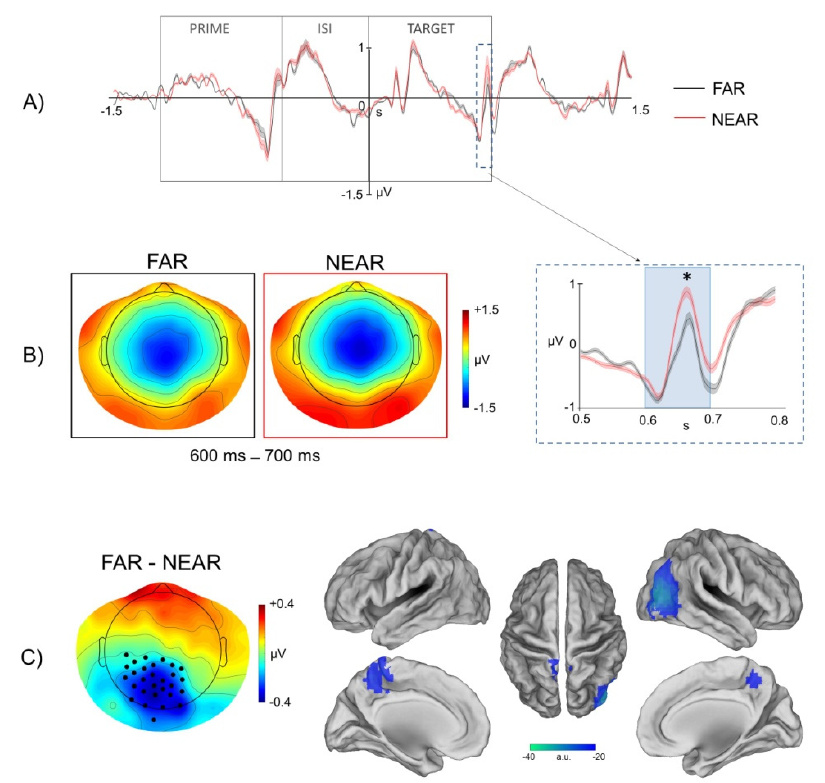
Figure 5. ERP modulation in the 600-700 ms interval. ( A ). Time course of the mean ERPs (black: far extrapersonal distance, red: near extrapersonal distance) of channels over posterior areas significantly different in the paired t -test. The time window from 1500 ms before to 1500 ms after the target image onset is shown. The time intervals of prime image presentation, ISI and target image presentation are indicated. The signals inside the dashed box are zoomed in B. ( B ). Right: Time course of the mean ERPs for the far and near condition. Vertical lines display standard error of the mean across subjects of the ERP values. Gray box indicates the time interval in which far and near conditions are significantly different (* p < 0.05). Right: Mean topography across subjects of scalp electric potentials in the significant time interval (from 600 to 700 ms) for the far (black box) and near (red box) conditions. ( C ). Left: Far vs. near difference of scalp topographies. Stars indicate EEG channels with a significant far vs. near difference, as evidenced by the paired t -test. Blue colors indicate a negative difference, i.e., the ERP components values of far condition are lower than the ERP components values of near condition. Right: Far vs. near difference of cortical source activity obtained by eLORETA of grand-average ERPs in the significant time interval. Blue colors indicate a negative difference, i.e., cortical activity lower in far than in near